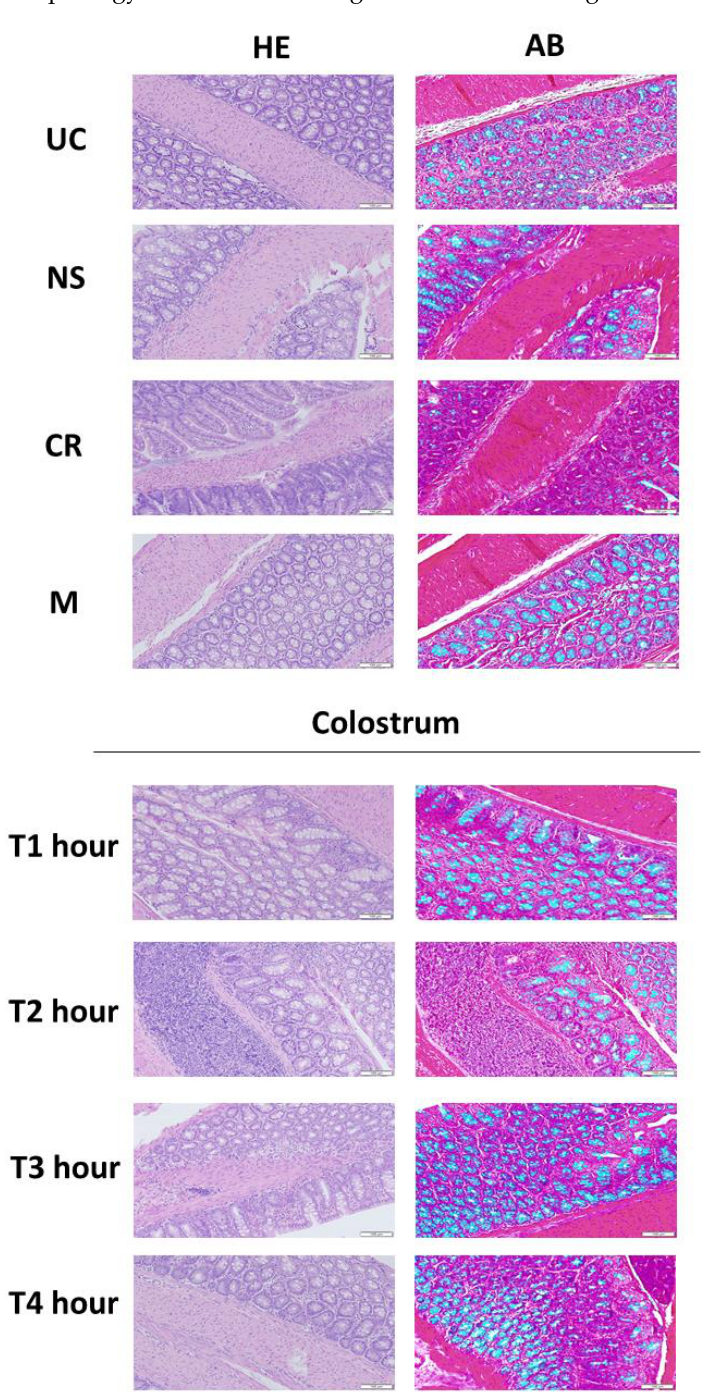
Figure 8. The feeding with bovine colostrum induced histological changes and mucus production in the intestine of Wistar rats in a colostrum collection fraction-dependent manner. Animals received colostrum collected at 1–4 h postpartum (T 1–4 h) as well as saline (NS), colostrum replacer (CR), and milk (M) that served as control. The feeding-induced changes were characterized by using hematoxylin-eosin (HE) and alcian blue (AB) staining. The size bar represents 100 µm.